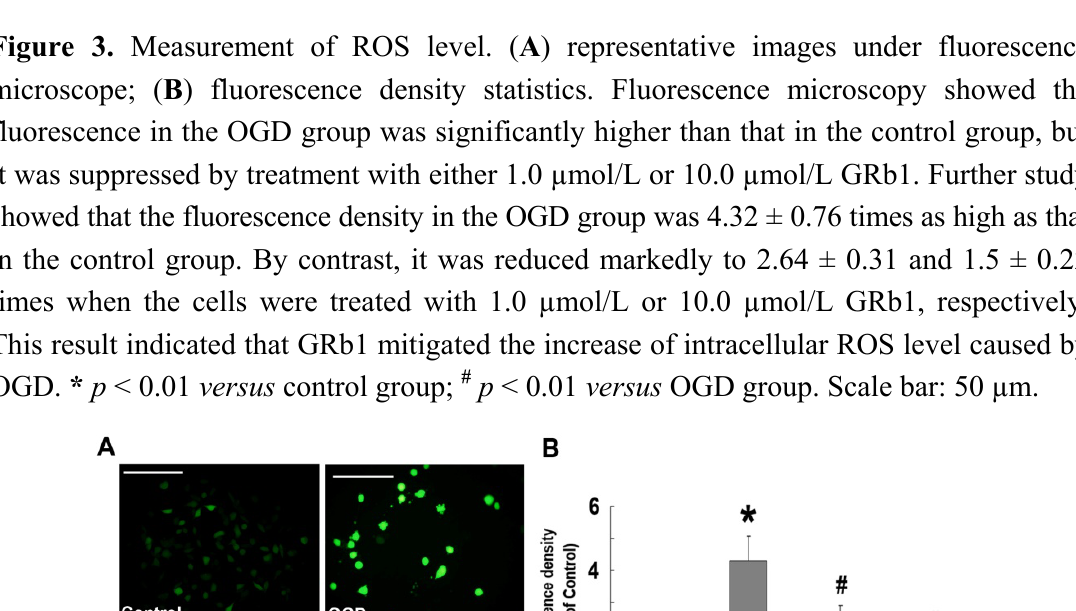
Figure 3. Measurement of ROS level. ( A ) representative images under fluorescence